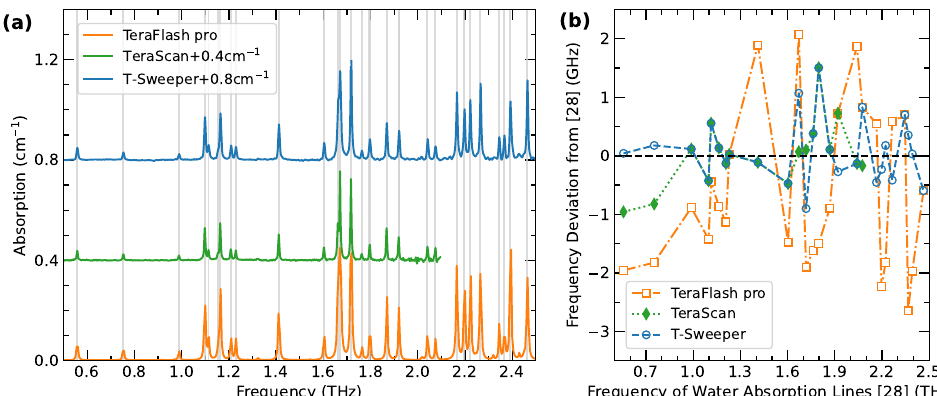
Figure 3. ( a ) Absorption spectrum of atmospheric water vapour measured by T-Sweeper, TDS and FDS. The grey vertical lines correspond to the values from HITRAN. ( b ) Deviations of the measured lines from the line data listed by HITRAN